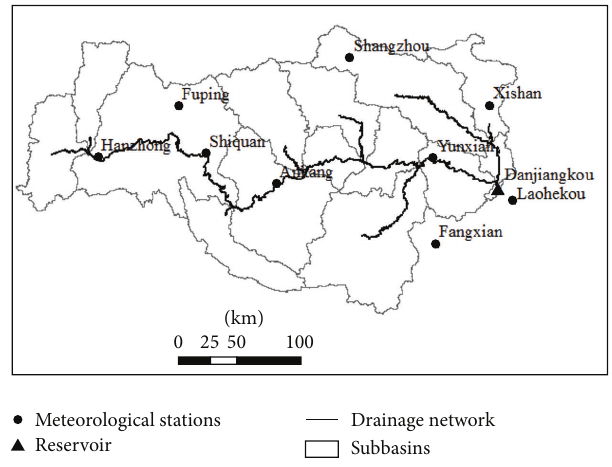
Figure 1: Locations of meteorological stations and reservoir in the study